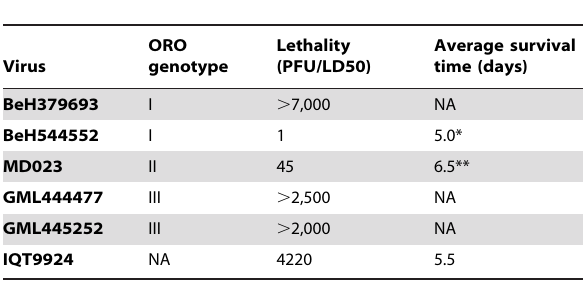
Table 6. Hamster virulence of ORO and IQT9924